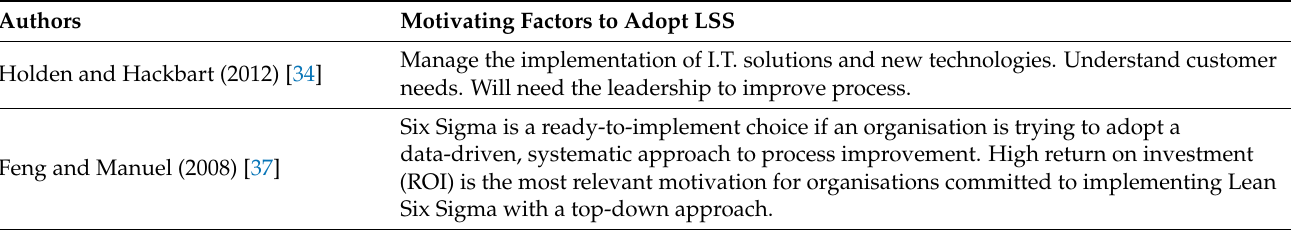
Table 1. Motivations for LSS in